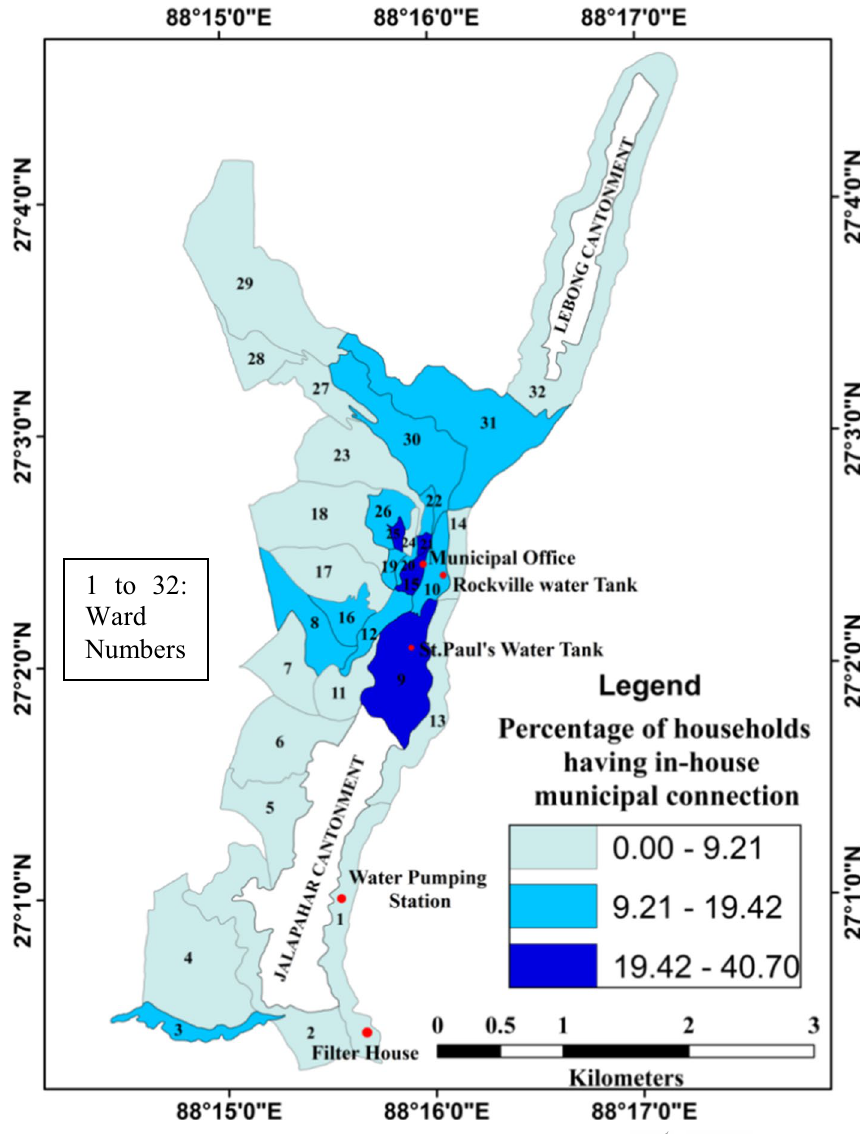
Fig. 4 Percentage of in-house water connections and main water points in the respective wards of Darjeeling municipal-